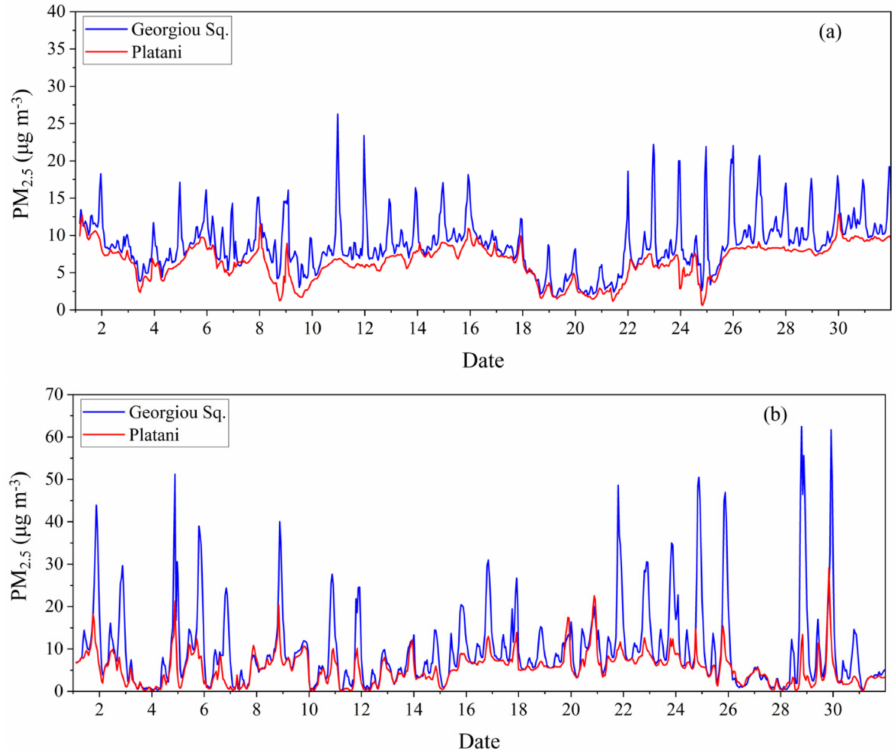
Figure 9. Predicted time series for PM 2.5 during ( a ) July 2021 and ( b ) December 2021 in Georgiou Sq. (center of the city) and Platani (outer suburbs). Different scales are